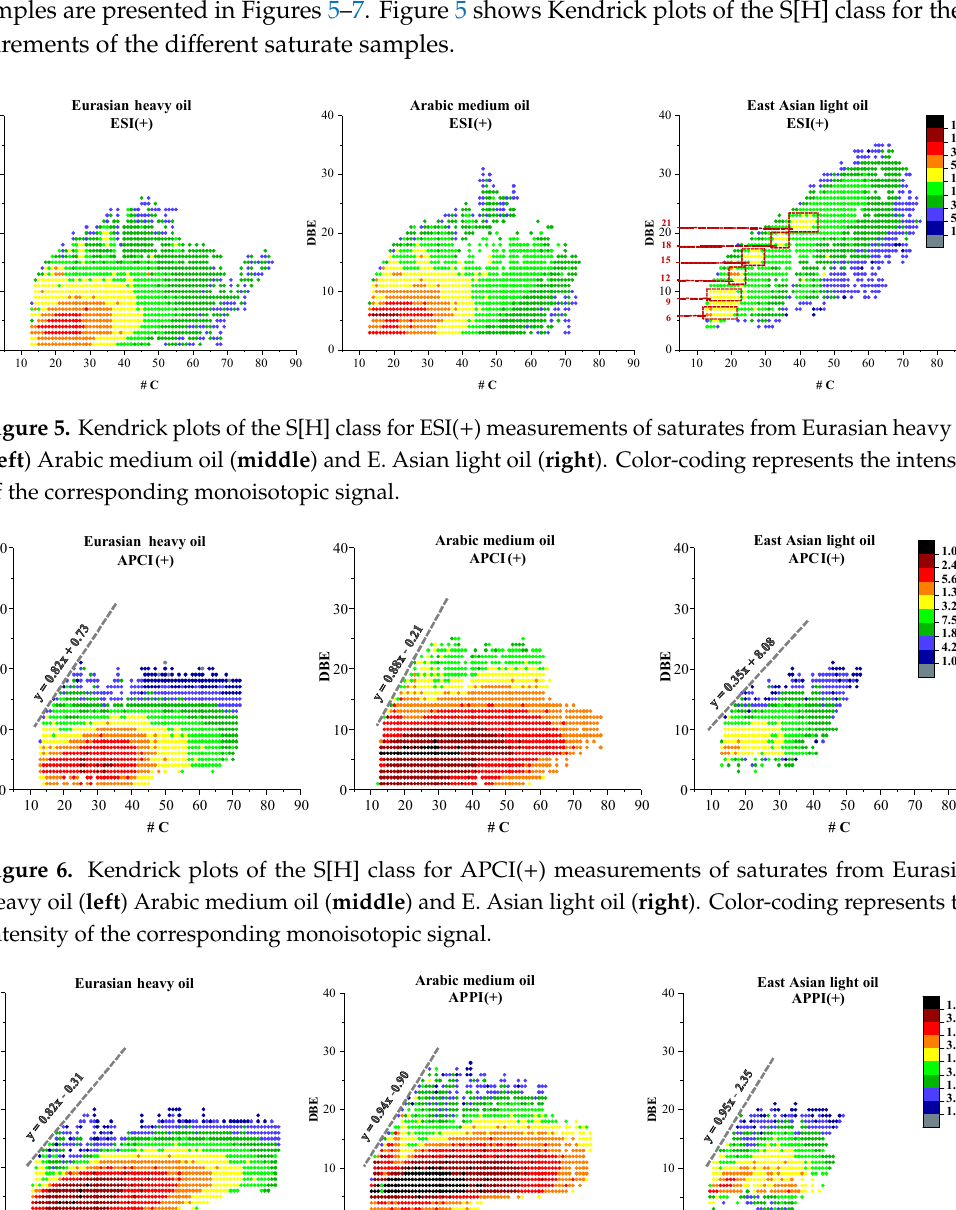
Figure 6. Kendrick plots of the S[H] class for APCI(+) measurements of saturates from Eurasian heavy oil ( left ) Arabic medium oil ( middle ) and E. Asian light oil ( right ). Color-coding represents the intensity of the corresponding monoisotopic signal .